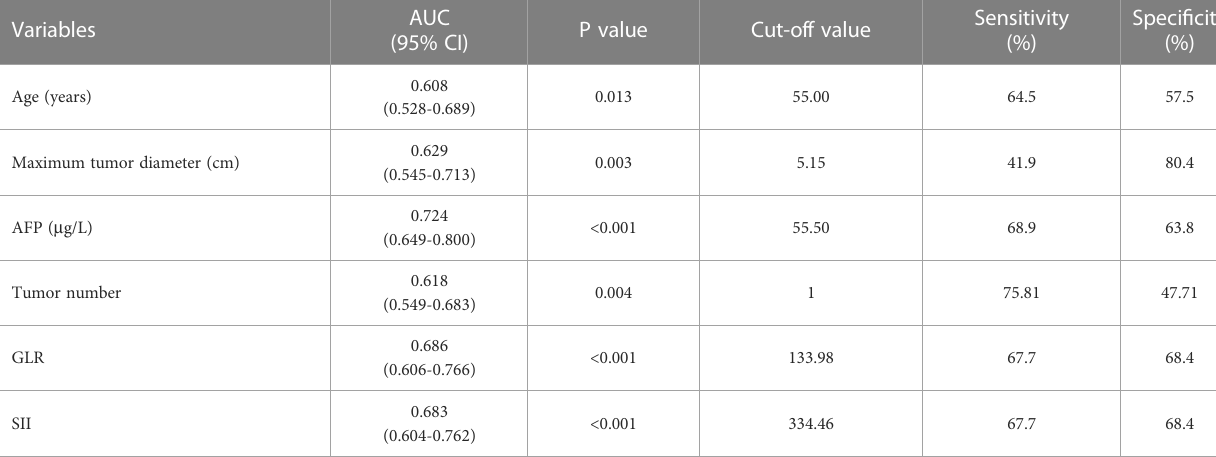
P<0.001) (Figure 6B).